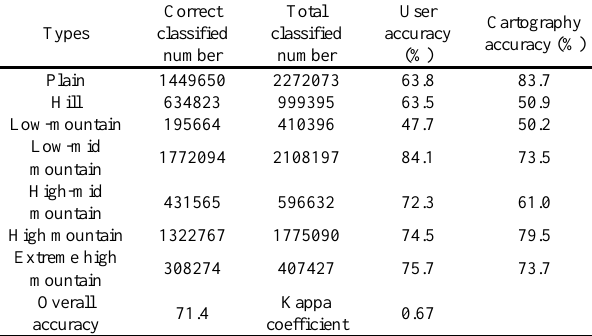
Table 2. Accuracy evaluation of classification result